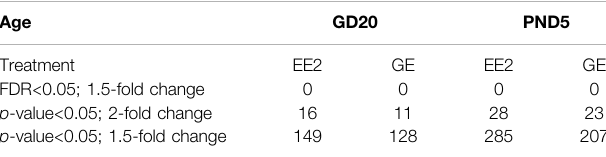
TABLE 2 | Number of differentially expressed genes (DEGs) using different sets of statistical